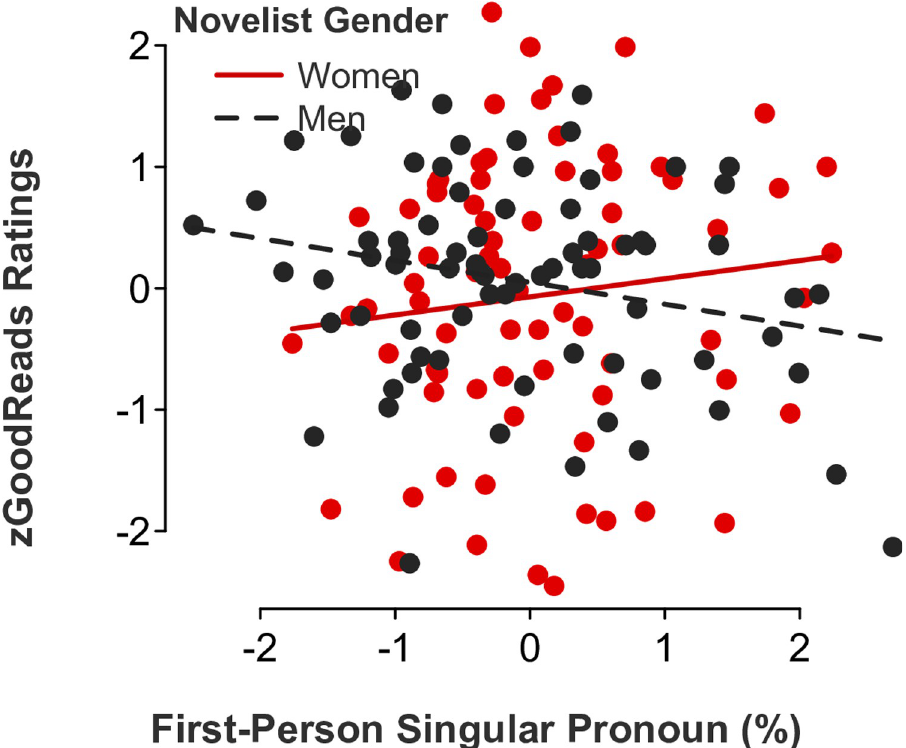
Fig 10. Novel ratings as a function of first-person singular pronoun use and novelist gender. https://doi.org/10.1371/journal.pone.0248402.g010 PLOS ONE | https://doi.org/10.1371/journal.pone.0248402 April 19,